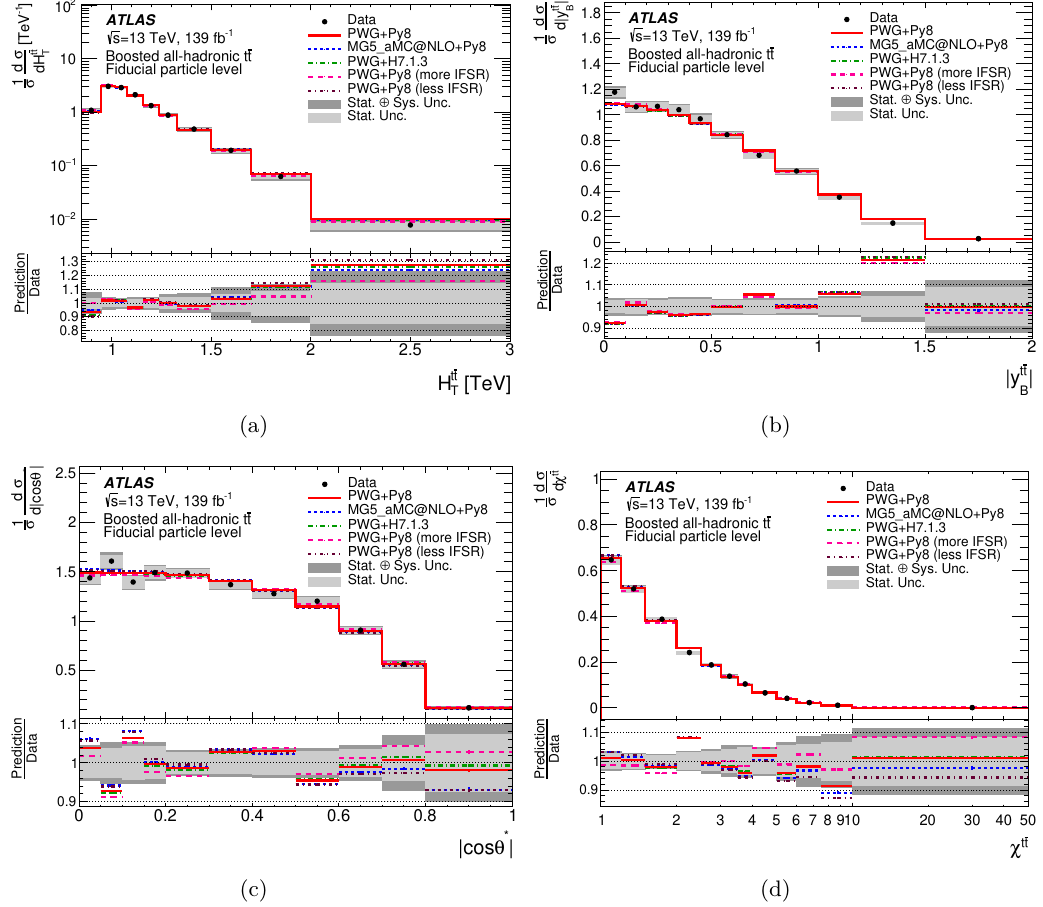
Figure 38 . Normalized particle-level fiducial phase-space differential cross-sections as a function of (a) the scalar sum of the transverse momenta of the top-quark jets, (b) the t ¯ t rapidity boost, (c) the production angle in the Collins–Soper reference frame, and (d) the production angle χ t ¯ t . The dark and light grey bands indicate the total uncertainty and the statistical uncertainty, respectively, of the data in each bin. Data points are placed at the centre of each bin. The Powheg+Pythia 8 MC sample is used as the nominal prediction to correct the data to particle